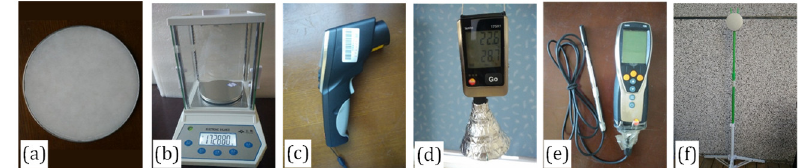
Figure 1. Experimental instruments or devices: ( a ) Naphthalene test specimen, ( b ) electronic balance, ( c ) infrared thermometer, ( d ) temperature and humidity recorder, ( e ) hot-wire anemometer, and ( f ) homemade bracket.